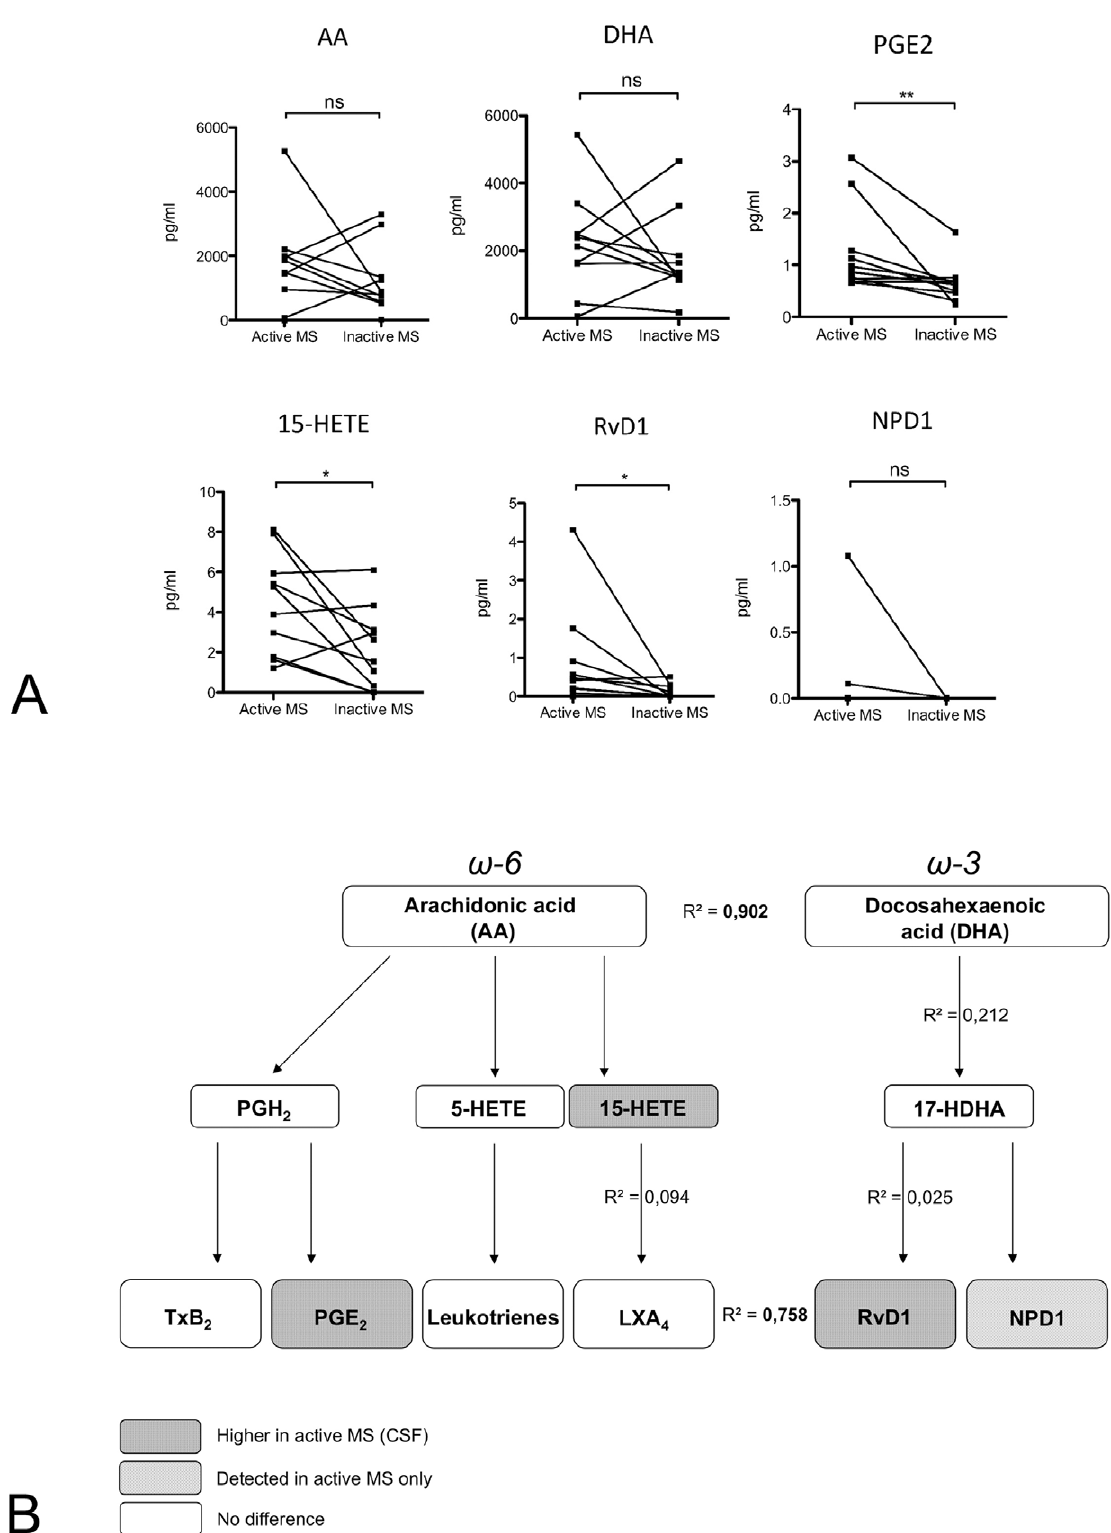
Figure 2. Pro-inflammatory and pro-resolution lipid mediators in CSF of patients with ‘highly active’ versus ‘less active’ MS. Released AA is converted into prostaglandins, leukotrienes, thromboxane, lipoxins, and hydroxy-eicosatetraenoic acids (HETEs), collectively termed eicosanoids. Lipoxygenase metabolism of DHA results in the generation of 17-HDHA, the resolvin D series and neuroprotectin D1. (A) Mass spectrometry detection in lumbar CSF suggests that the differences in the brain are very robust as the molecules are produced locally and become diluted during CSF flow. Precursors AA and DHA were similarly present in both disease phenotypes. PGE 2 , 15-HETE and the proresolution agonist